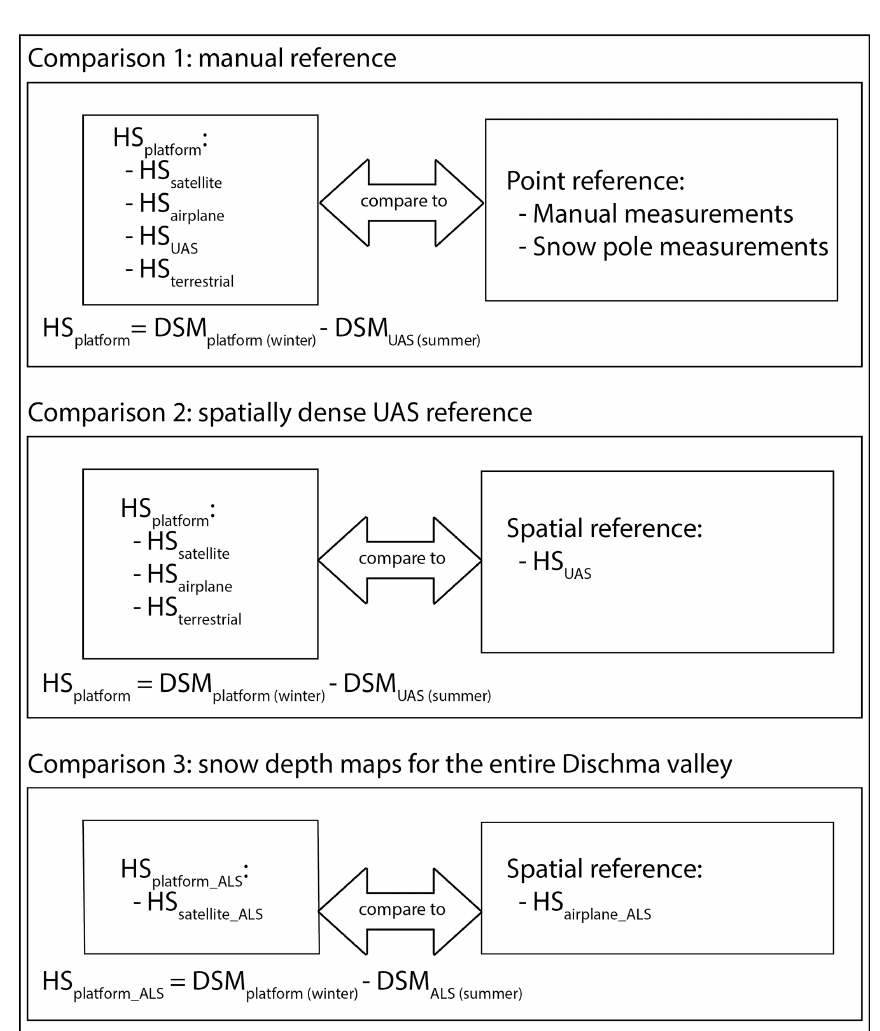
Figure 3. Flow chart illustrating the three comparison strategies. With HS platform we refer to the snow depth map of the respective platform. HS platform_ALS is the snow depth map of the respective platform calculated with the ALS summer